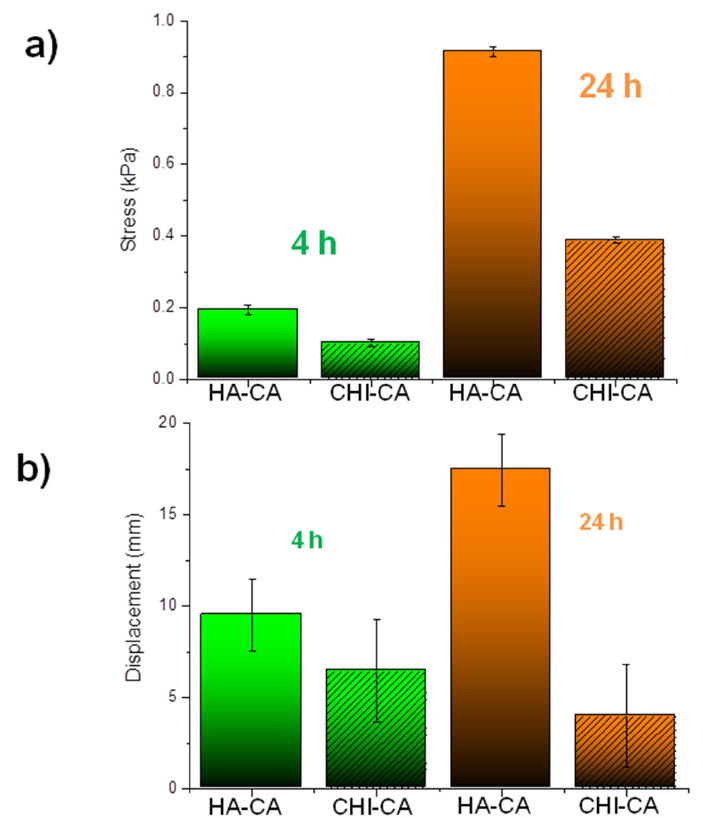
Figure 10. Comparative graph between the studied systems that gathers ( a ) the maximum stress applied to detach the sample from the skin and ( b ) the maximum elongations until rupture of the systems studied after 4 h (green) and after 24 h (orange) for HA-CA and CHI-CA hydrogels. n = 5.